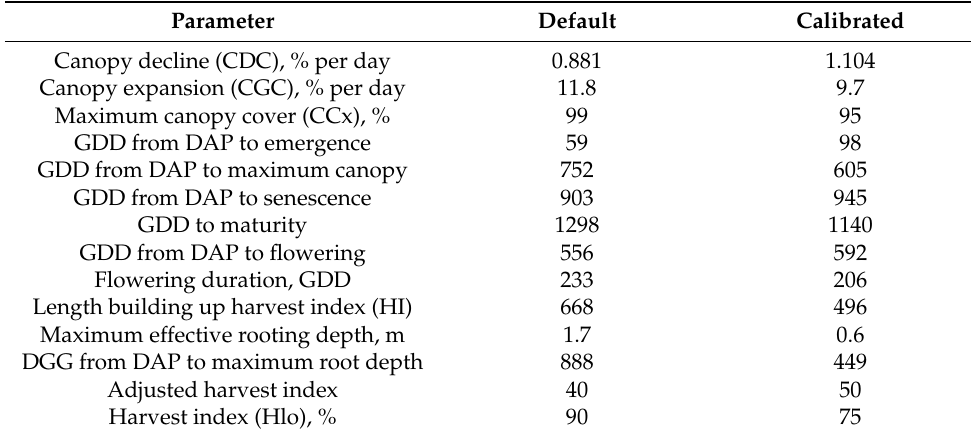
Table 3. Default and calibrated data, DAP—days after